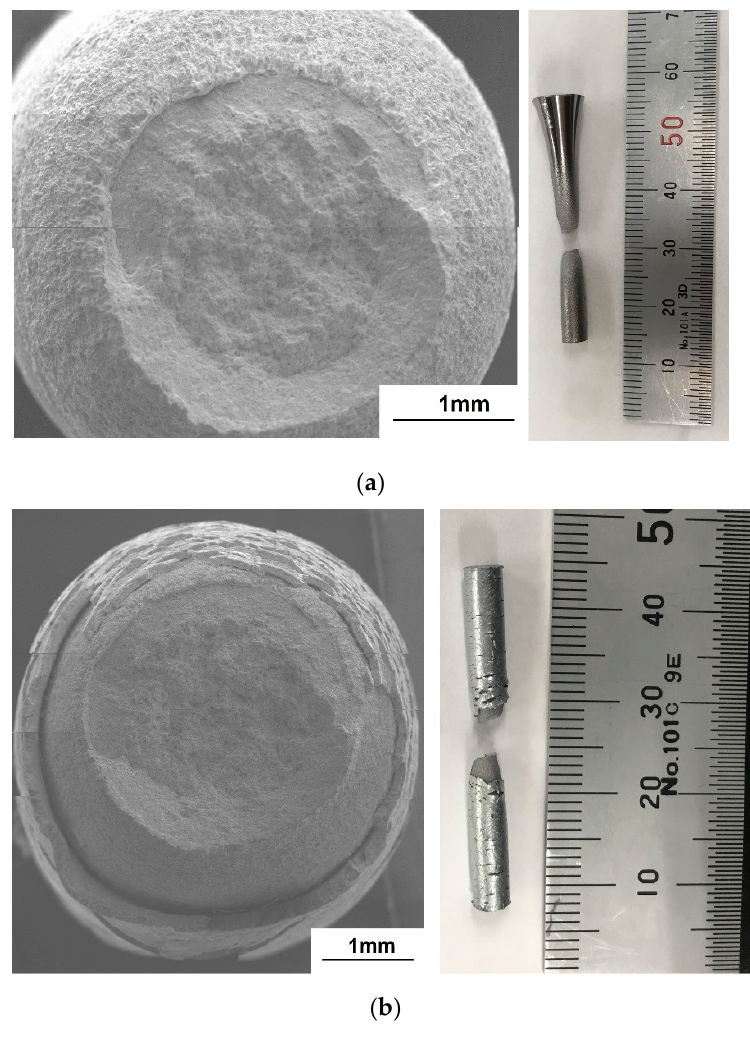
Figure 11. Fracture surfaces and optical photographs from the side near the failure site for normalized AISI 1020 steel at R = 0.5: ( a ) non-galvanized, σ max = 414.5 MPa and ( b ) galvanized, σ max = 377.8 MPa.